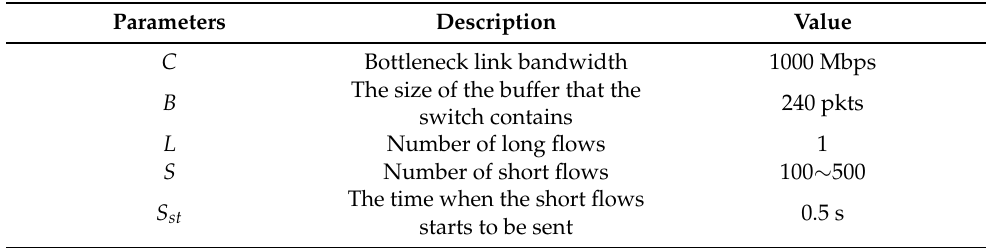
Table 1. Incast environment: experimental parameters for different ECN marking thresholds.